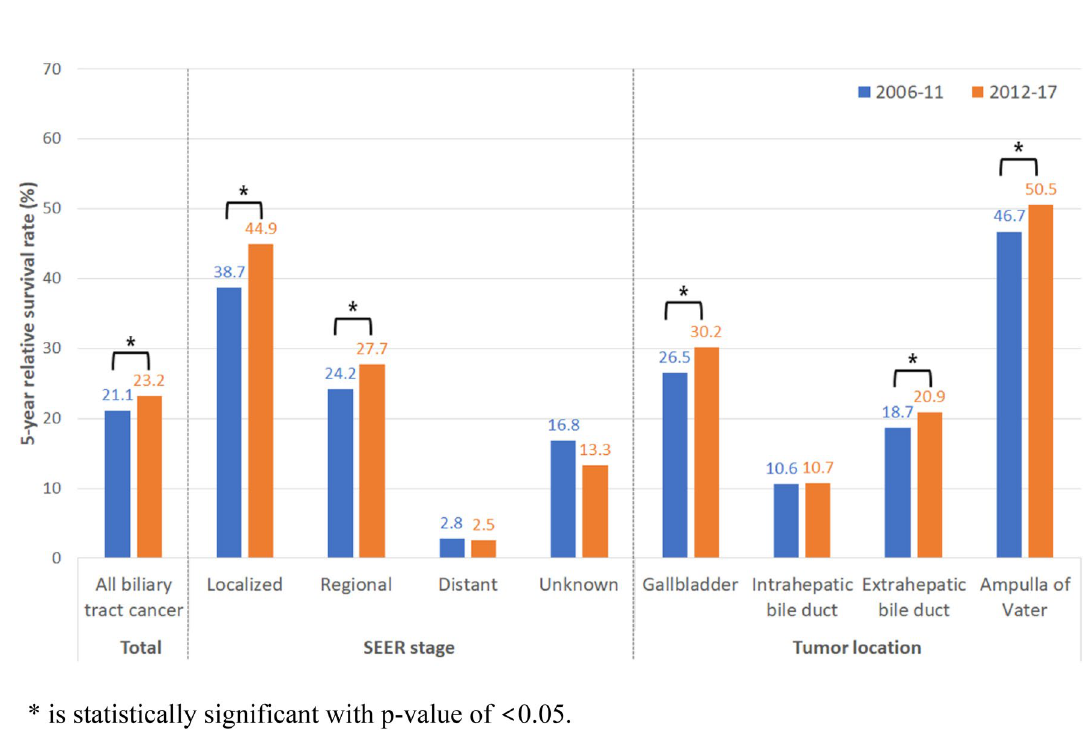
Figure 3. Five-year relative survival rate of biliary tract cancer according to tumor location and SEER